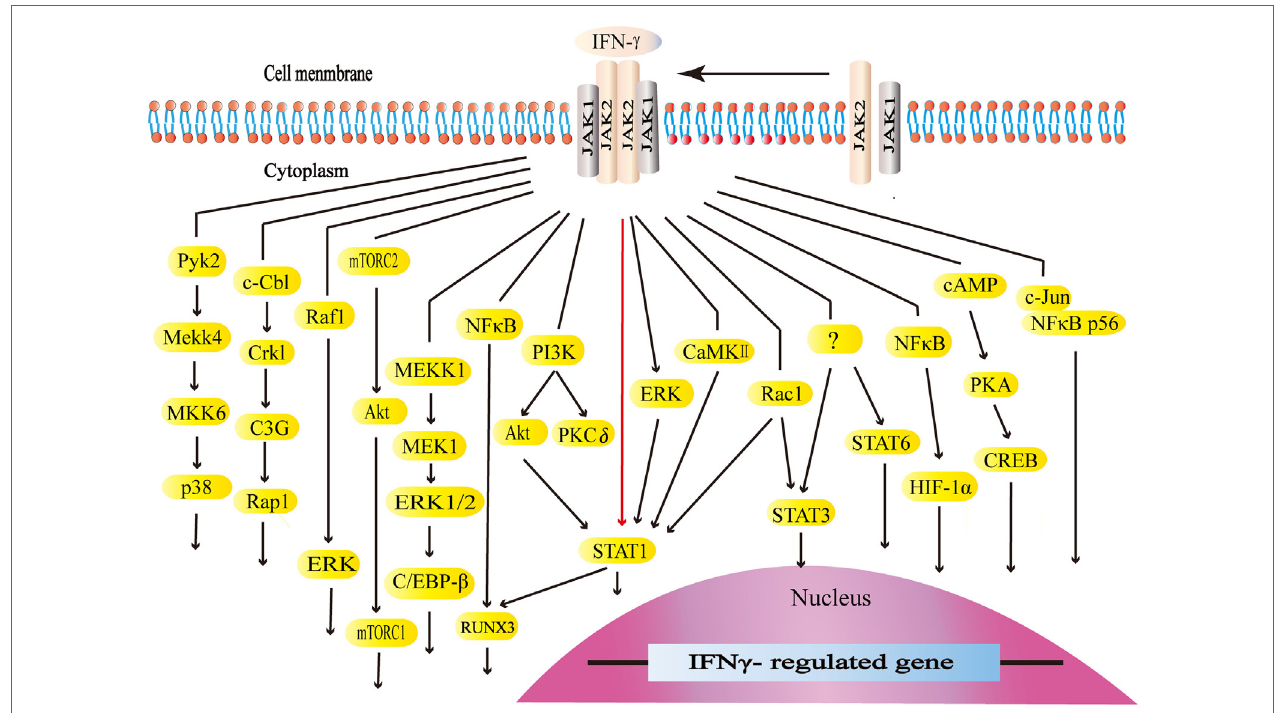
FiGURe 2 | The canonical and non-canonical signaling pathways of interferon-gamma (IFN- γ ). The JAK–STAT1 is the canonical signaling pathway. Apart from JAK–STAT1, IFN- γ activates other downstream factors. IFN- γ activates the kinase like PI3K, Pyk2, extracellular signal-regulated kinase (ERK), and CaMKII as well as GTPases like Raf1 and Rac1 to initiate multiple downstream signaling cascades. IFN- γ stimulates E3 ubiquitin-protein ligase c-Cbl, NF- κ B, c-Jun, and cAMP, which are also involved in multiple